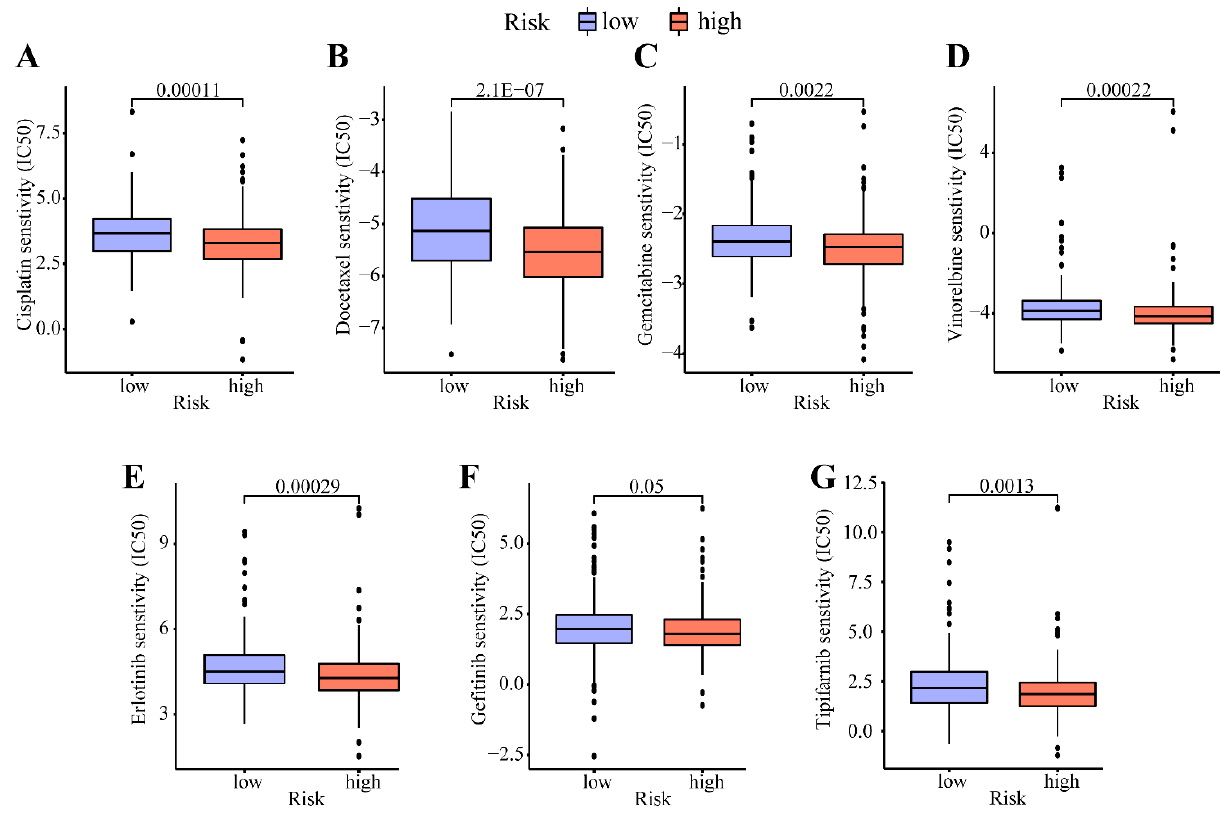
Figure 6. Association between the risk score and drug susceptibility. The boxplots show the difference in the half maximal inhibitory concentration (IC50) of ( A ) cisplatin, ( B ) docetaxel, ( C ) gefitinib, ( D ) vinorelbine, ( E ) erlotinib, ( F ) gefitinib, and ( G ) tipifarnib between the high- and low-risk group.